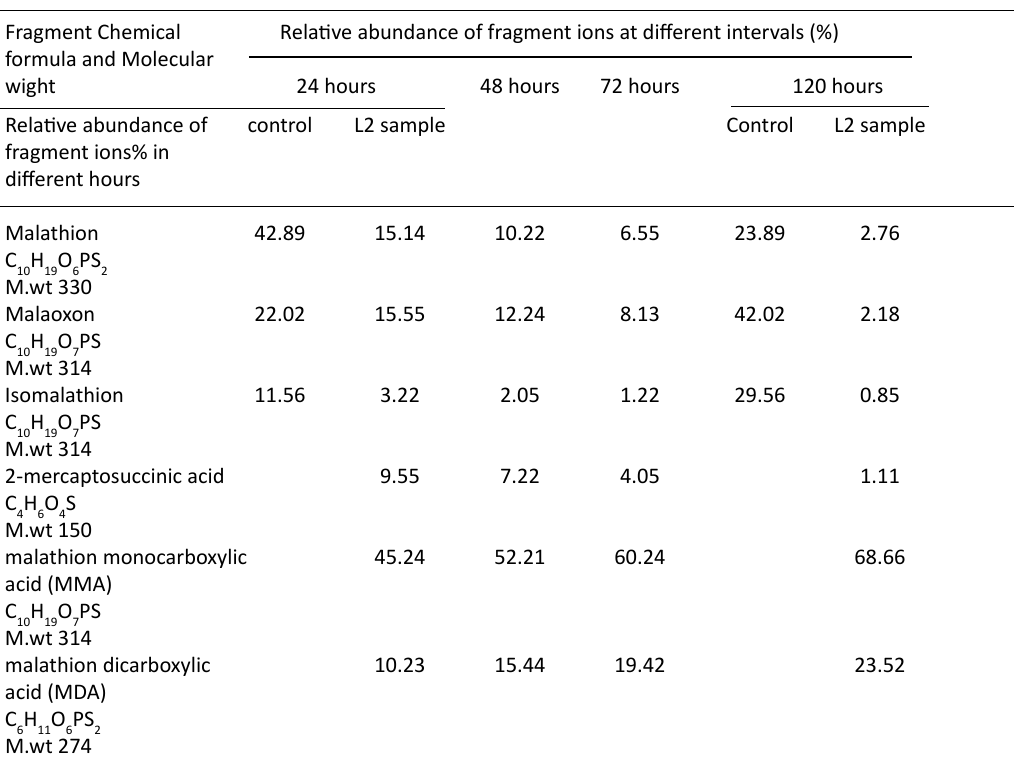
Table 2. The relative abundance of Malathion and its metabolites fragment ions in L2 treatment Fragment Chemical Relative abundance of fragment ions at different intervals (%) formula and Molecular 24 hours Relative abundance of control L2 sample Control L2 sample fragment ions%